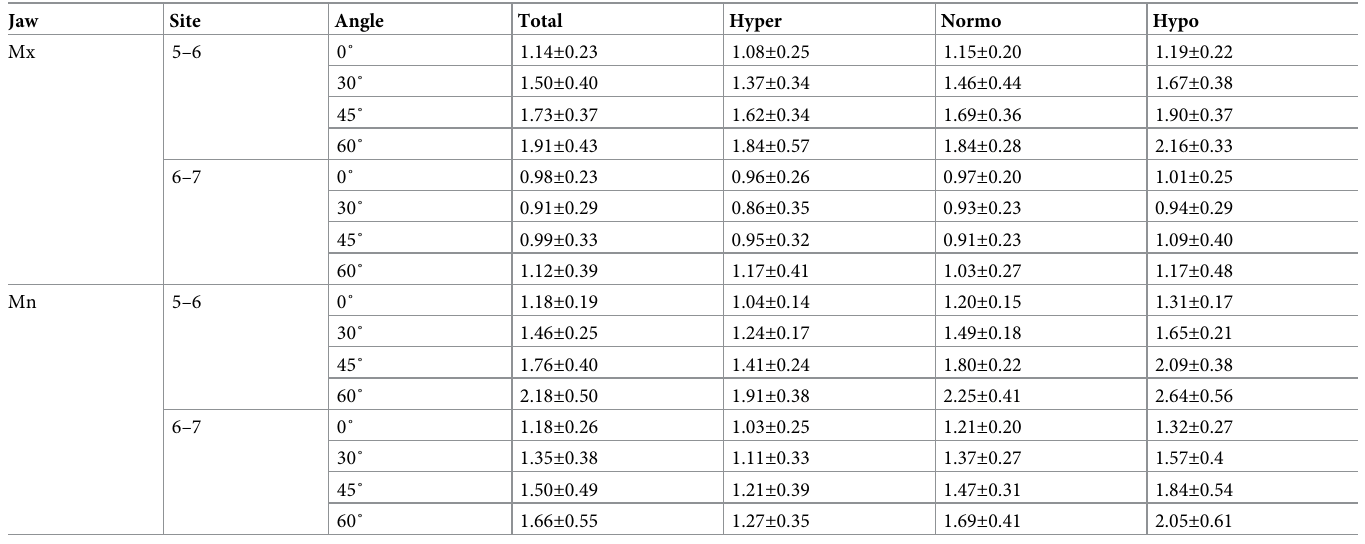
Table 3. The means and standard deviations of measurable miniscrew–root distance values (unit: mm). Jaw